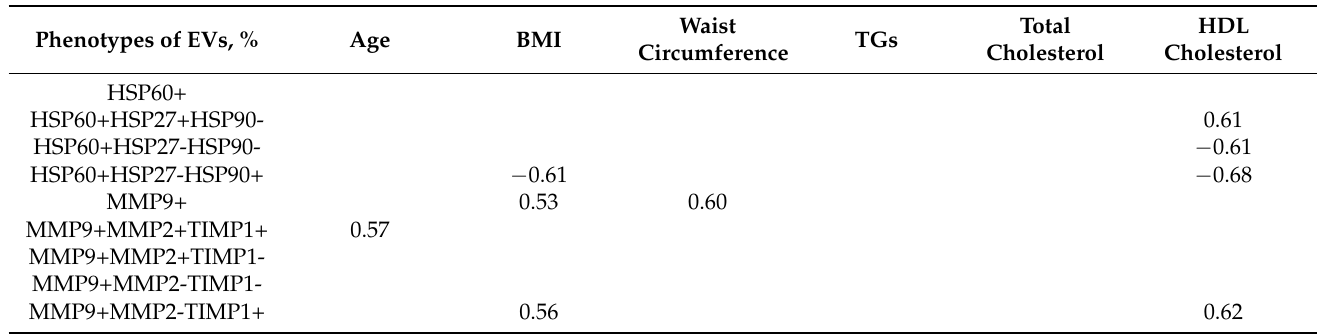
Table 3. Spearman correlation coefficients (r) between CD9-positive sEVs phenotypes and age, BMI, waist circumference, TGs, total cholesterol, and plasma high-density lipoprotein (HDL) cholesterol in CRCPs *.